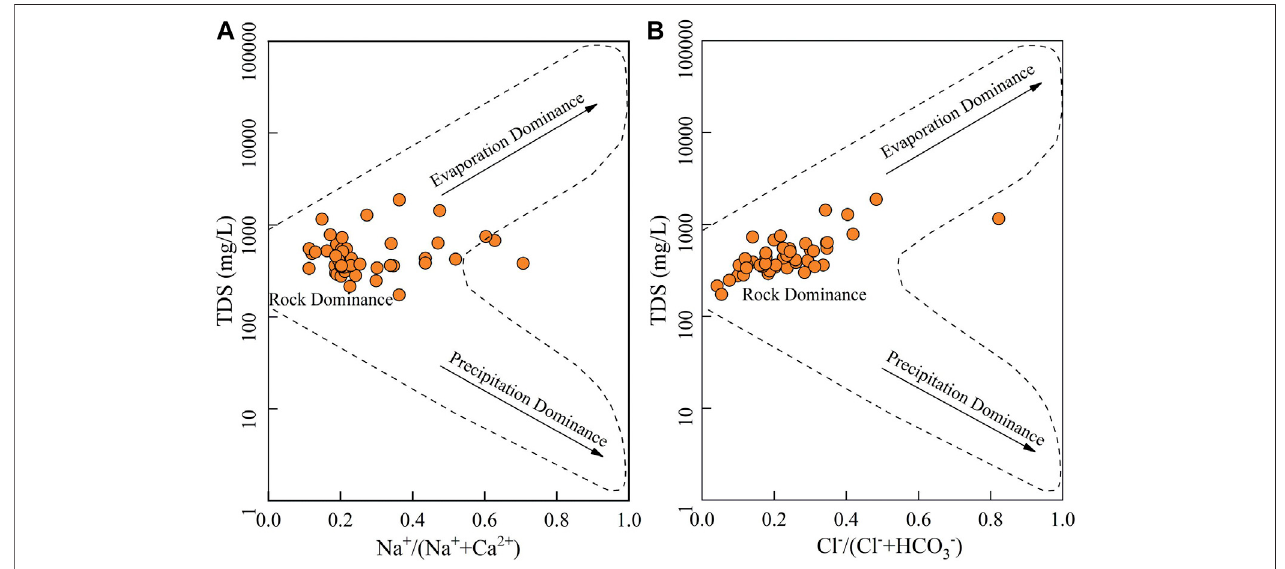
FIGURE 4 | Gibbs diagrams illustrating the natural processes controlling the chemical compositions of phreatic groundwater in the study area.